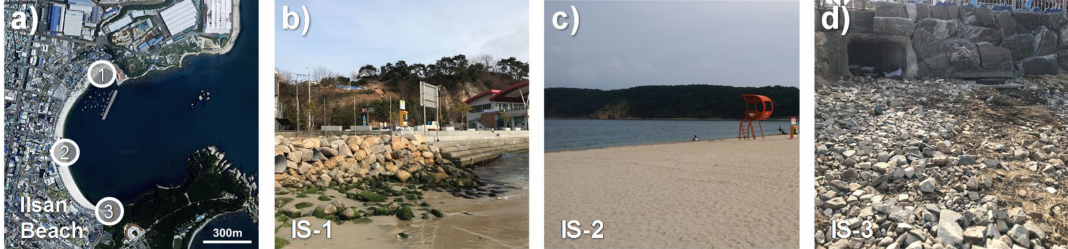
Figure 5. ( a ) Satellite photograph of Ilsan Beach, South Korea, and sampling locations at the beach: beach seawater samples were collected at: ( b ) the northern end (1, denoted as IS-1), ( c ) the middle of the beach (2, denoted as IS-2), and ( d ) at the southern end (3, denoted as